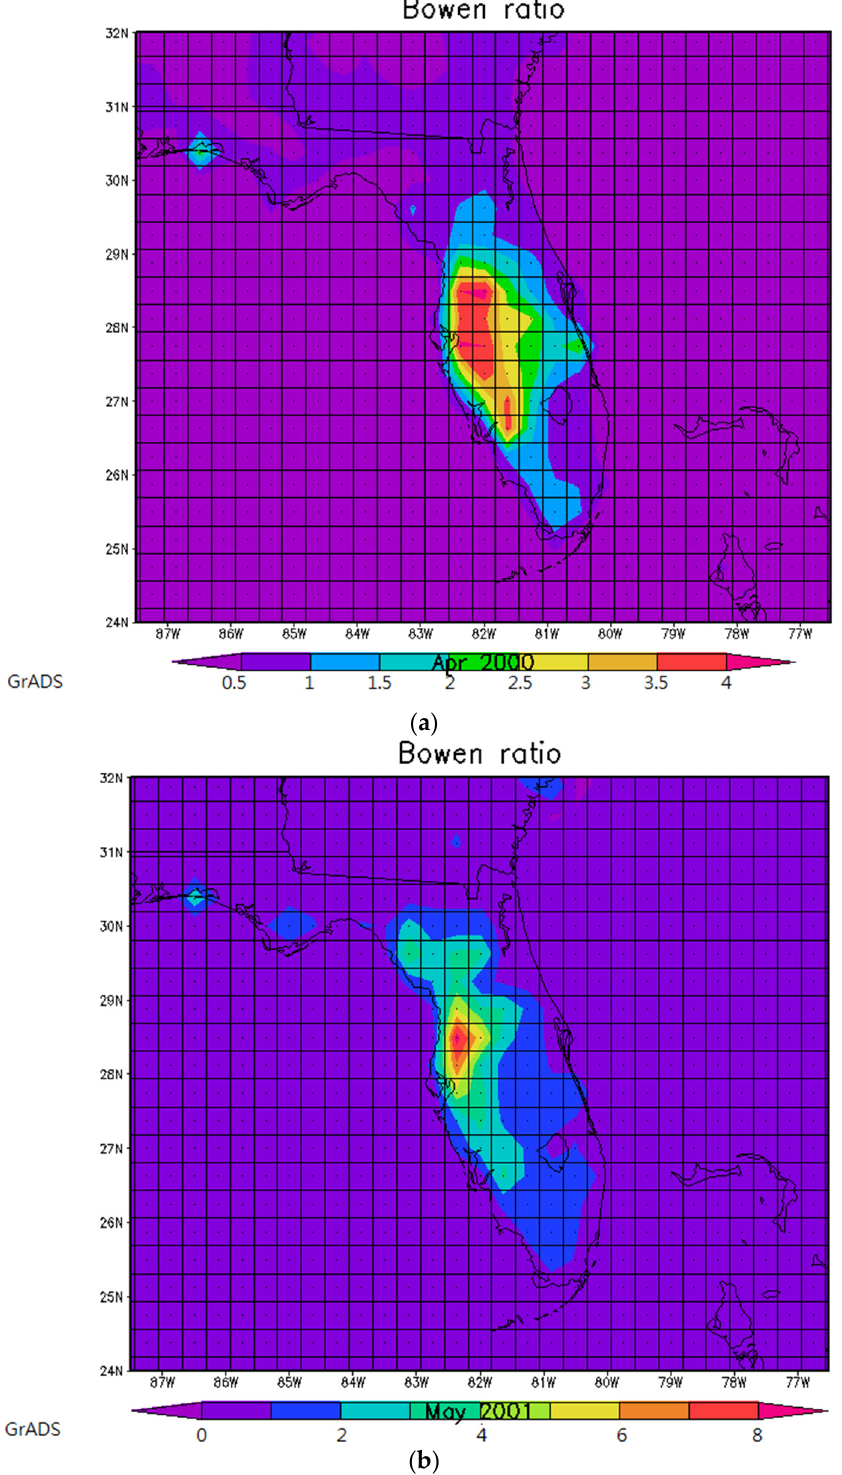
Figure 10. ( a , b ) Maps of Bowen Ratio in ( a ) April 2000 and ( b ) May 2001 over Florida.